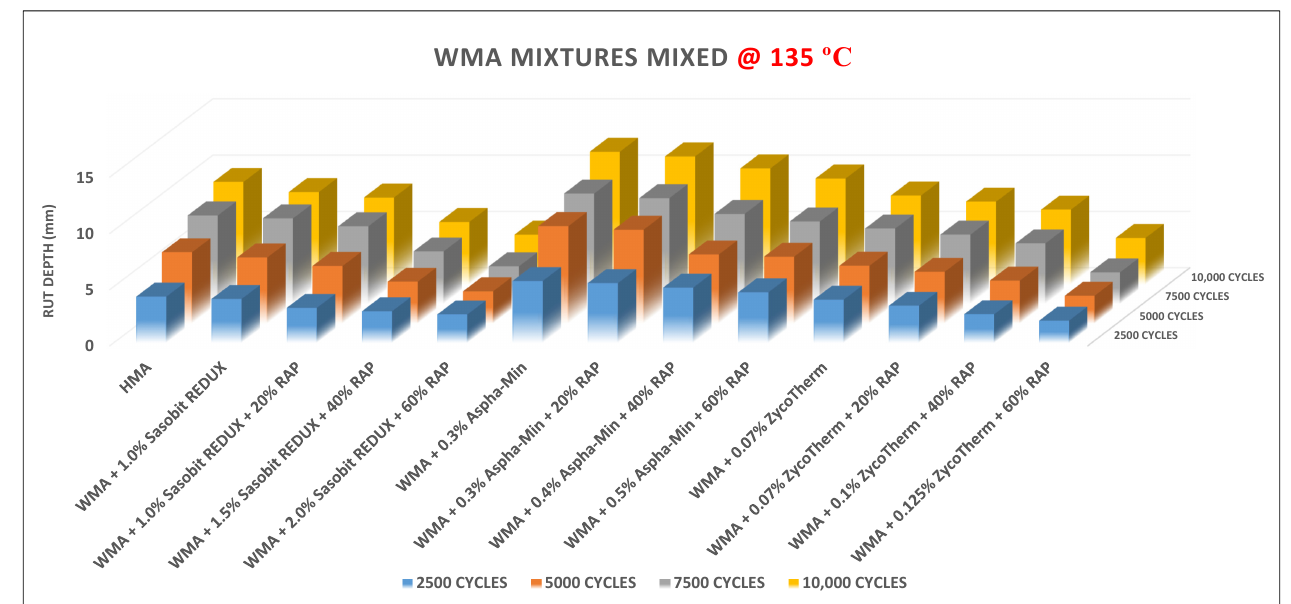
Figure 22. Rutting depth for the modified virgin and recycled WMA mixtures mixed @ 135 °C.